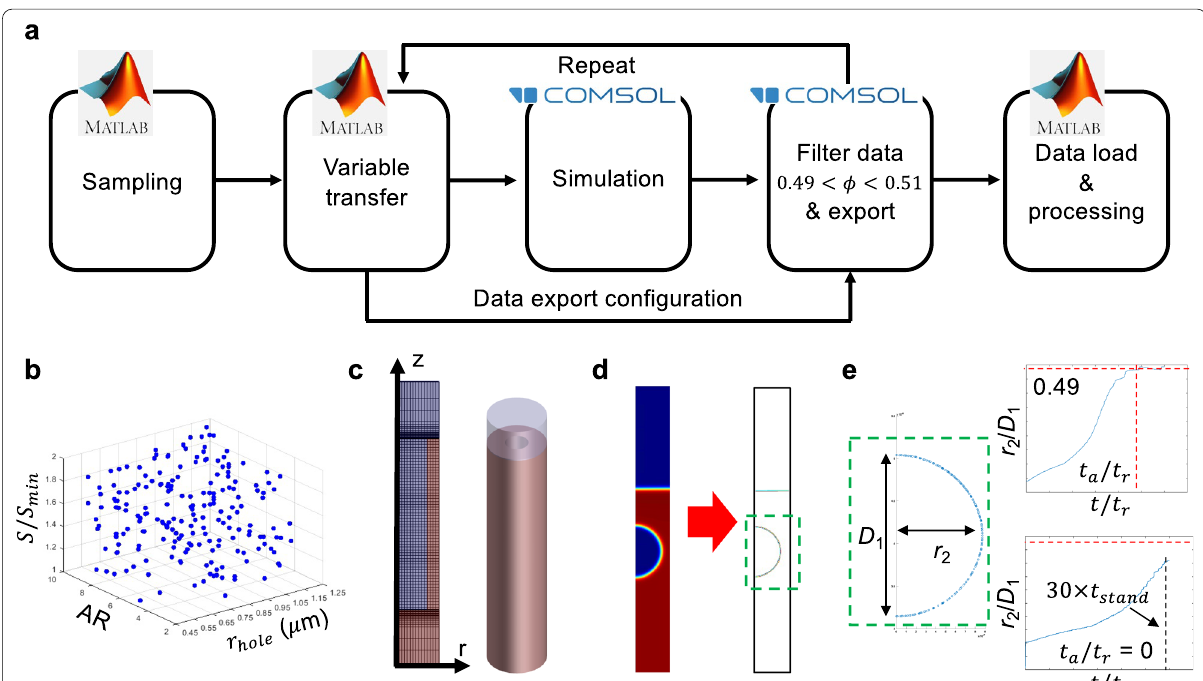
Fig. 4 Data sampling process; a overall process, b Latin hypercube sampling of 200 samples, c simulation, d filtering, and e data processing